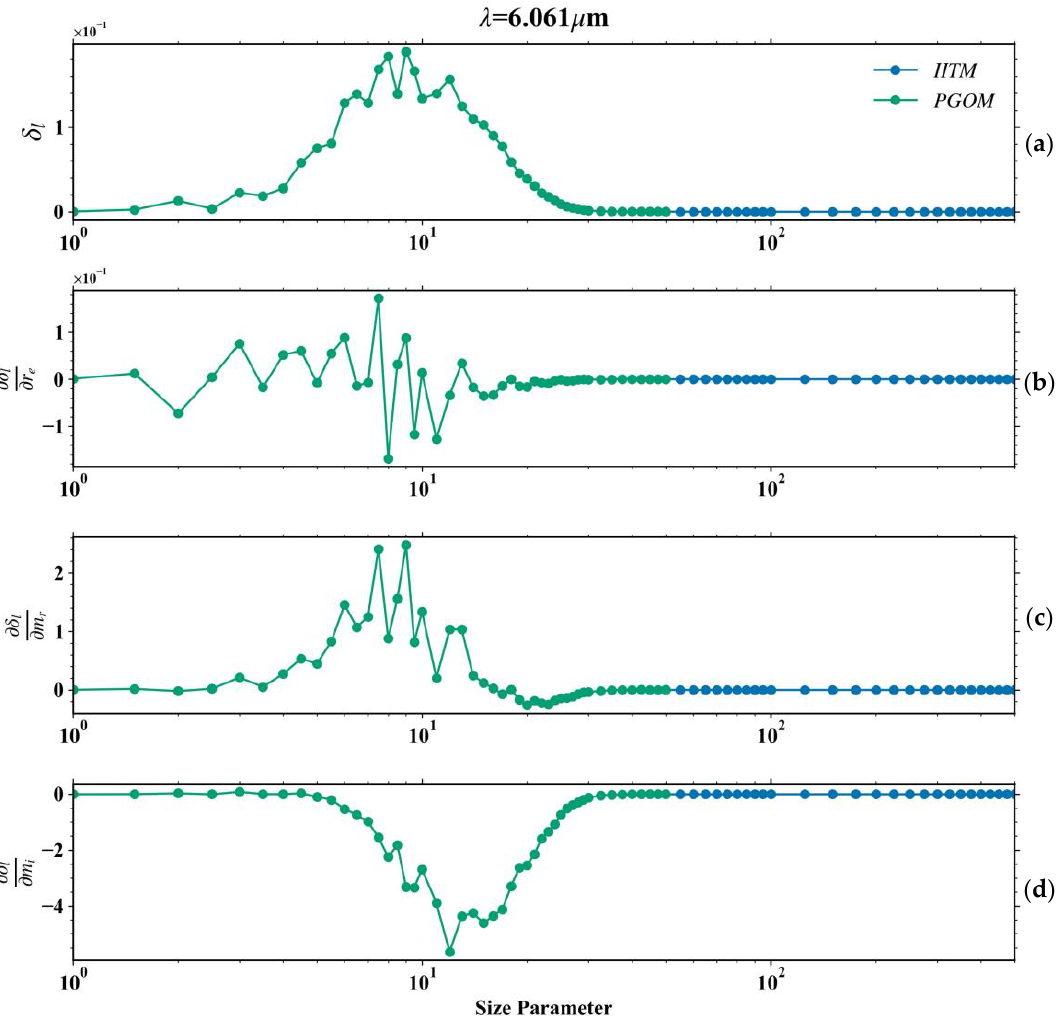
Figure 10. Linear backscattering depolarization ratio ( a ) and its partial derivatives with respect to effective radius ( b ) and refractive index( c , d ).